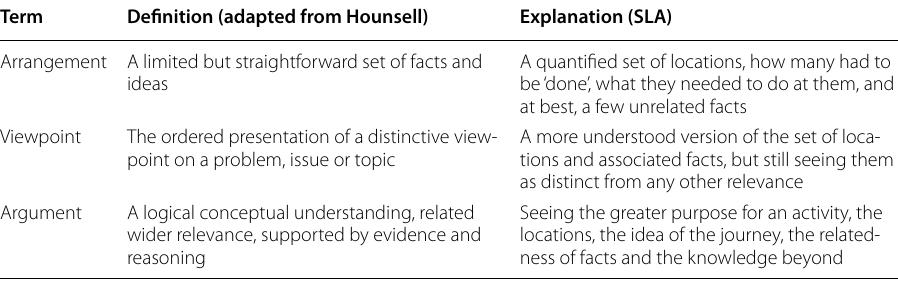
Table 5 Adapting Hounsell’s arrangement, viewpoint, argument for smart learning activities